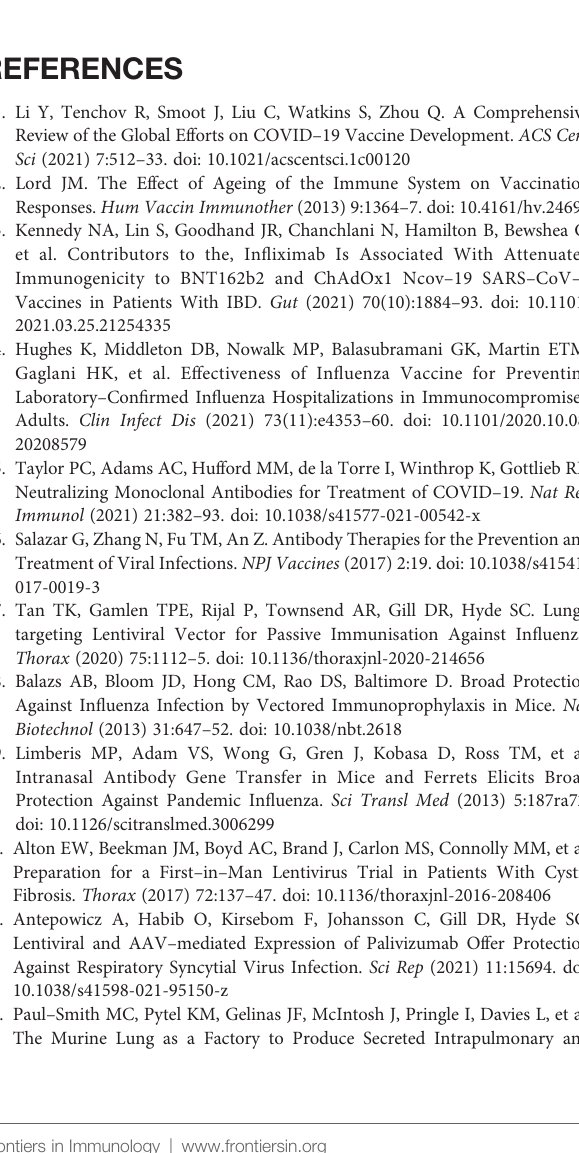
Supplementary Figure 1 | Mapping of residues involved in the interaction between the RBD and NC0321. (A) Residues that contribute substantially to interactionsbetweenRBDandNC0321. (B) Predictionofcrucialhydrogen-bonding residues for the interactions between RBD and NC0321. Supplementary Figure 2 | Prophylactic ef fi cacy of rSIV.F/HN-NC0321 in mouse- adapted SARS-CoV-2 surrogate model. (A) The NC0321 IgG levels in BALF and ELF of groups of young and SCID mice were determined by ELISA 21 dpi with 5E8 TU rSIV.F/HN-NC0321.at the day of infection using ELISA assay (n = 3, t-test, ns represents p > 0.05). (B) Bioluminescence imaging value (photons/sec/cm2/sr) for each animal in Figure 3A was computed, symbols represent individual animals and bars represent group mean ± SEM (ANOVA, Dunnett ’ s multiple comparison between isotype and NC0321 treated BALB/c mice. ns represents p > 0.05, * represents p = 0.0381 and *** represents p < 0.001, n = 4-8 per group). (C) Bioluminescent imaging for each animal in Figure 3A . (D) Human IgG expression in sera (left) and ELF (light) of animals in Figure 3A , separated by gender (n = 3-4, ns represents p > 0.05, non-parametric